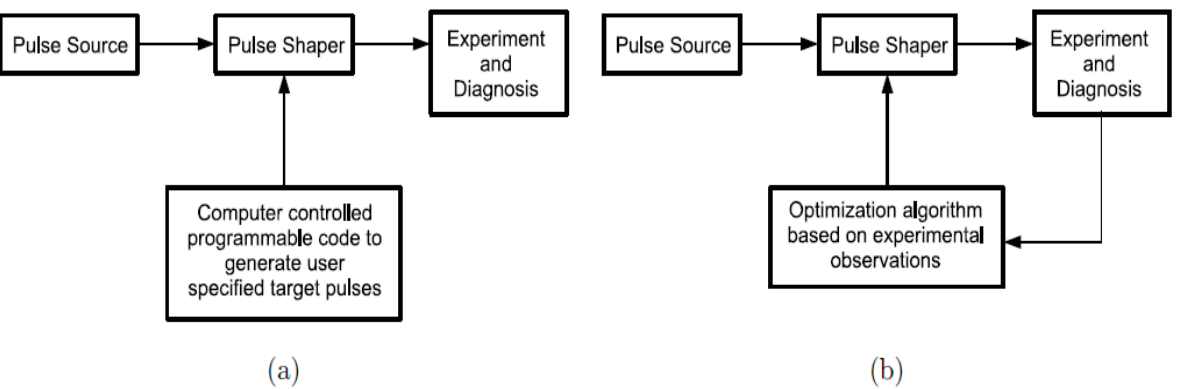
Figure 1. Control schemes for optical pulse shaping. ( a ) Open loop control. ( b ) Feedback (adaptive